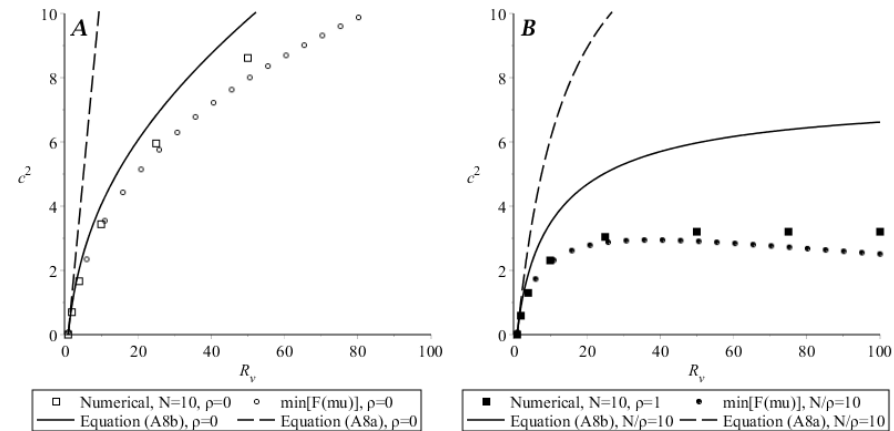
Figure A5. Steady autowave speed (squared) as a function of R v in the numerical solution (Equa- tion (1), squares) and estimated using Equations (A5) (circles), (A8a) (dashed lines), and (A8b) (solid lines). ( A ) ρ = 0, ( B ) ρ = 1. Other parameters are the same as in Figure